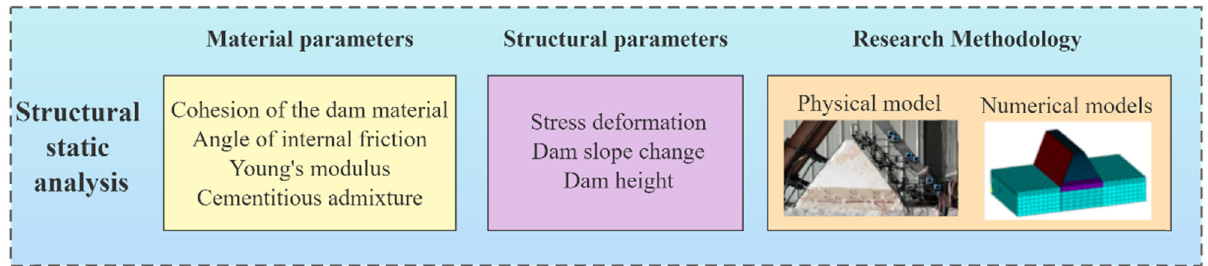
Figure 2: Generalized diagram of the static analysis of a CSG dam ( images taken from literature [ 55,56 ])